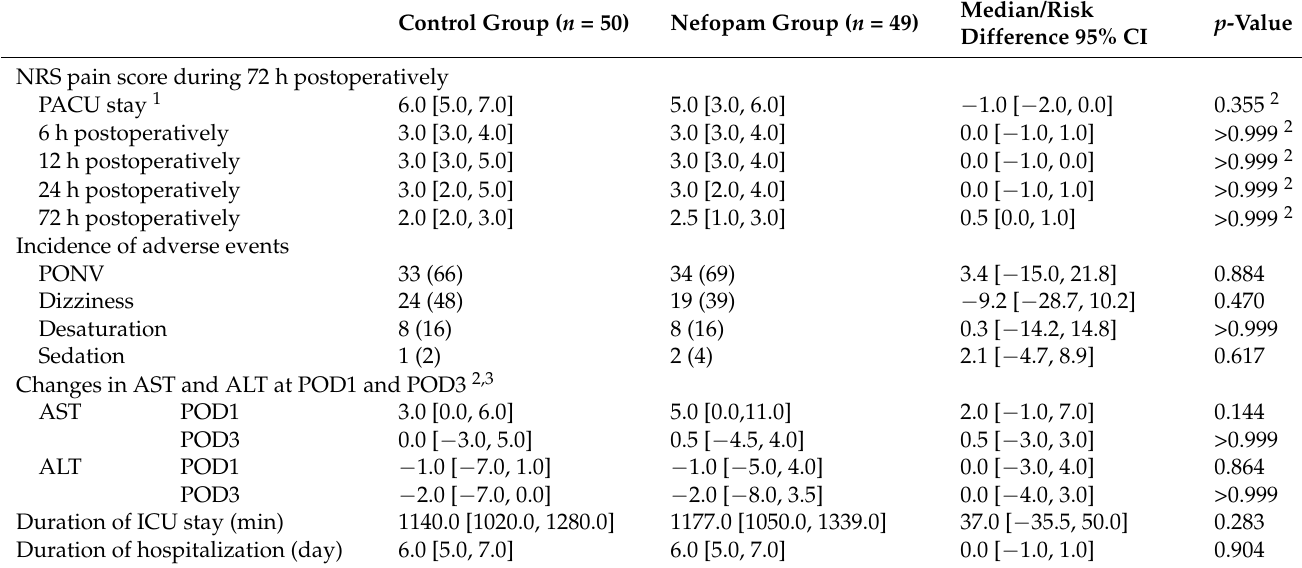
Table 3. NRS pain scores at each time point and postoperative clinical outcomes between the groups.